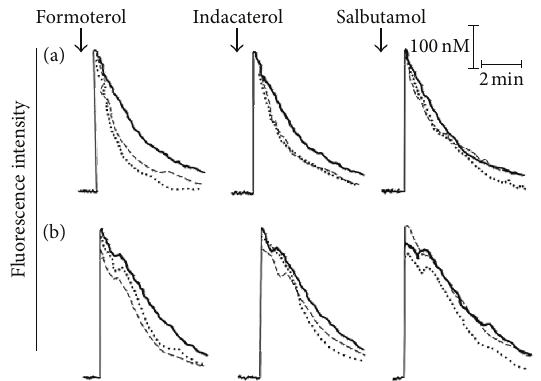
Figure 6: Fura-2 fluorescence traces from 2 representative exper- iments ( 𝑛 = 4 – 7 in the series) showing the effects of formoterol, indacaterol, and salbutamol (10 and 100nM) on the alterations in cytosolic Ca 2+ concentrations following activation of the cells with either 1 𝜇 M fMLP (a) or 200 nM PAF (b). The 3 lines in each trace correspond to the control system (—) and systems treated with either 10nM ( ) or 100 nM ( eeeee ) of each drug; ↓ denotes the addition of either fMLP or PAF.